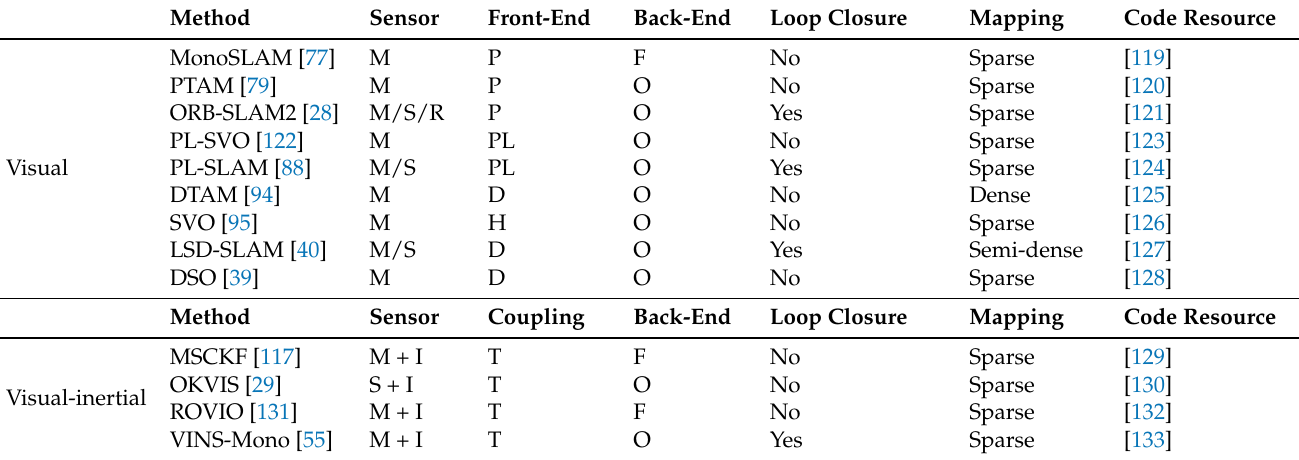
Table 7. Best visual-based SLAM